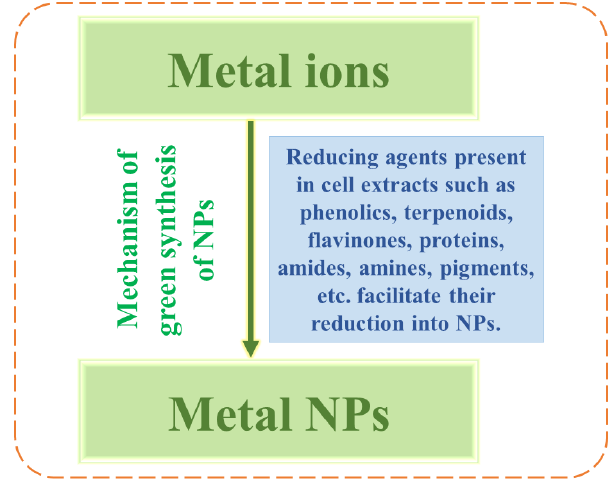
Figure 4. Mechanism of nanoparticle synthesis via reduction of metal ions. The ion transport system present in microbial cells facilitates intracellular production. Positively charged metal ions are attracted to the negatively charged bacterial cell wall where they are reduced by the embedded enzymes to respective metallic NPs. Reductases are secreted by the microbial cells in case of extracellular production and stabilisation where metal ions are reduced into NPs in the medium, which could be easily retrieved. As for an example, green synthesised ligninase-dependent Au NPs have been produced using fungus Phanerochaete chrysosporium intracellularly and was found to be highly stable [52]. Other examples with details are mentioned in Table 1. Table 1. Various nanoparticles via different biological resources.